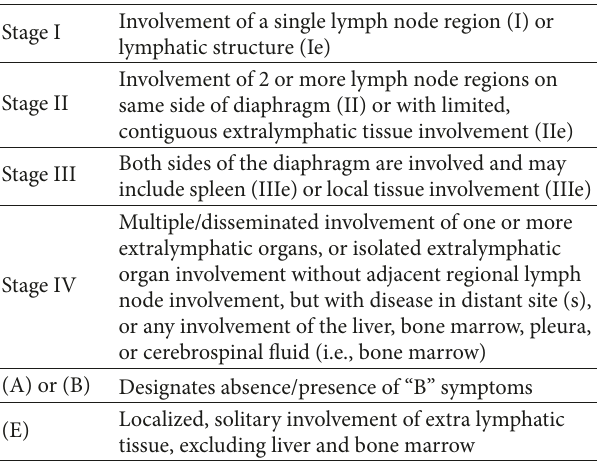
Table 1: Ann Arbor staging